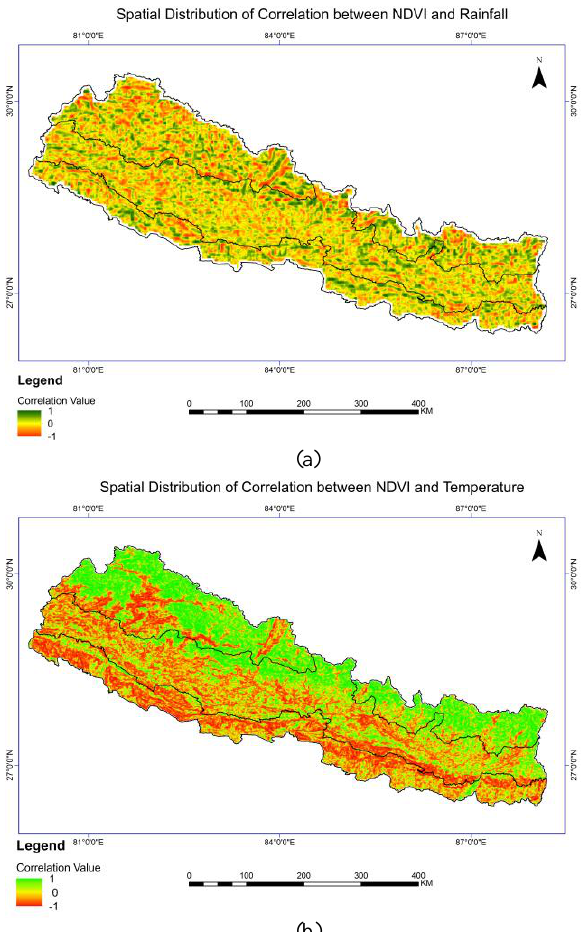
Figure 7. Spatial distribution of correlation between mean NDVI and climate factors (a. rainfall b. temperature) for six months’ period